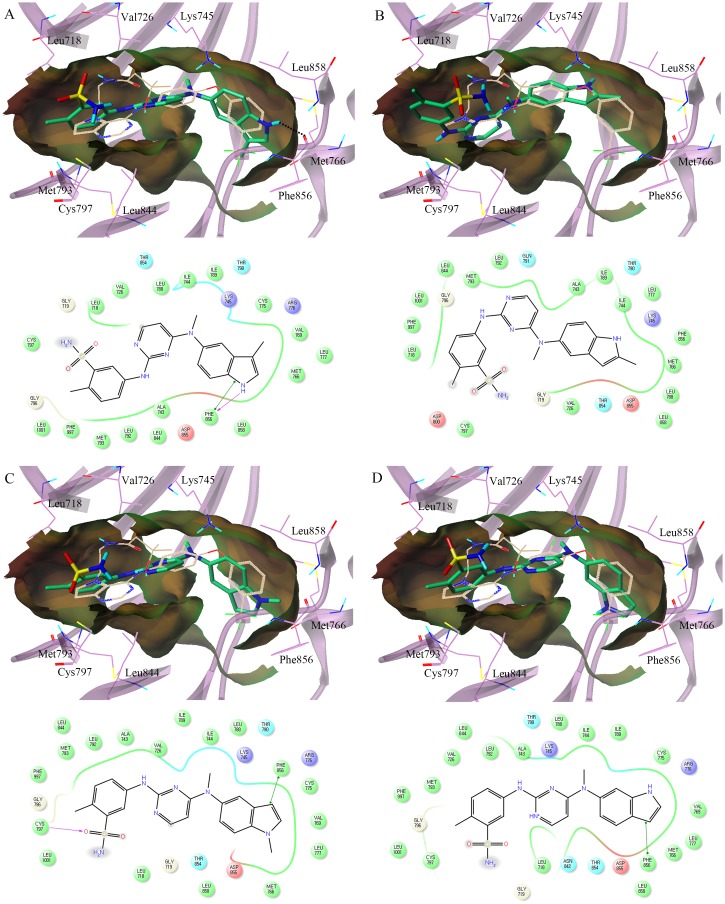
Comparison of the binding configurations of the MKP101 analogues.(A) MKP102, (B) MKP103, (C) MKP104, and (D) MKP105 (carbon atoms in green) with TAK-285 (carbon atoms in ivory). Hydrogen bonds are displayed as dashed lines. The lipophilic potential surface of the ATP-binding site of EGFR was created using the MOLCAD implemented in Sybyl-X 2.0. In the 2D-interaction diagram, acidic, hydrophobic, basic, polar, and other residues at the active site are represented by red, green, purple, blue, and gray spheres, respectively. Hydrogen bonds between the ligand and backbone are shown in dashed pink lines. The π-π stacking interaction is shown with a green line. Similar to MKP101, the 3-methyl indole moiety of MKP102 occupies a lipophilic pocket that forms a direct hydrogen bond with the backbone of Phe856. However, MKP103 the 2-methyl indole derivative, cannot fit into the lipophilic pocket because of the steric hindrance of the methyl group. The N-methyl indole MKP104 and the 6-amino indole MKP105 lost hydrogen bonding with Phe856 owing to the structural change. ATP, adenosine triphosphate; EGFR, epidermal growth factor receptor; 2D, 2-dimensional.